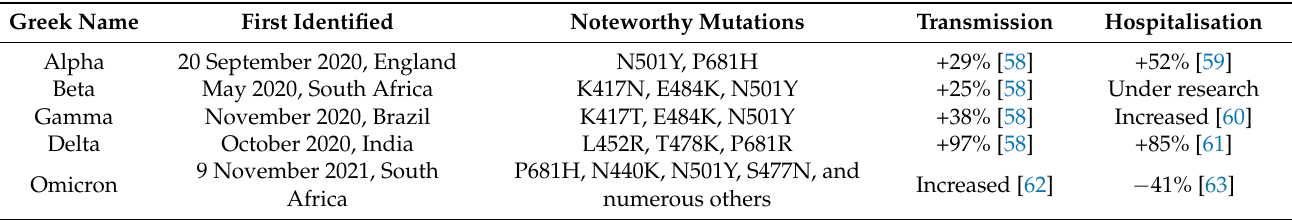
Table 1. SARS-CoV-2 variants of